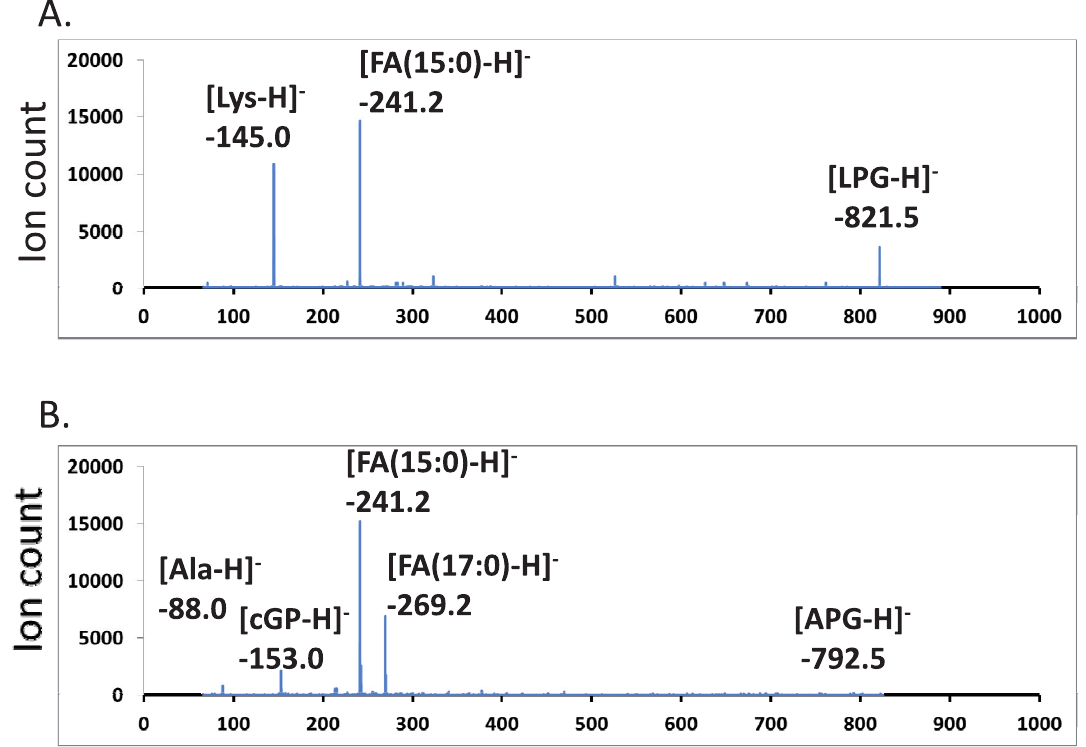
Figure 2. Tandem mass spectra of deprotonated lysyl-PG and alanyl-PG. Major peaks in the MS/MS spectra are labeled. FA – fatty acid, LPG – (30:0) lysyl-PG, APG – (32:0) alanyl-PG, cGP – cyclo-glycerol-phosphate. A . MS/MS spectrum of lysyl-PG. B . MS/MS spectrum of